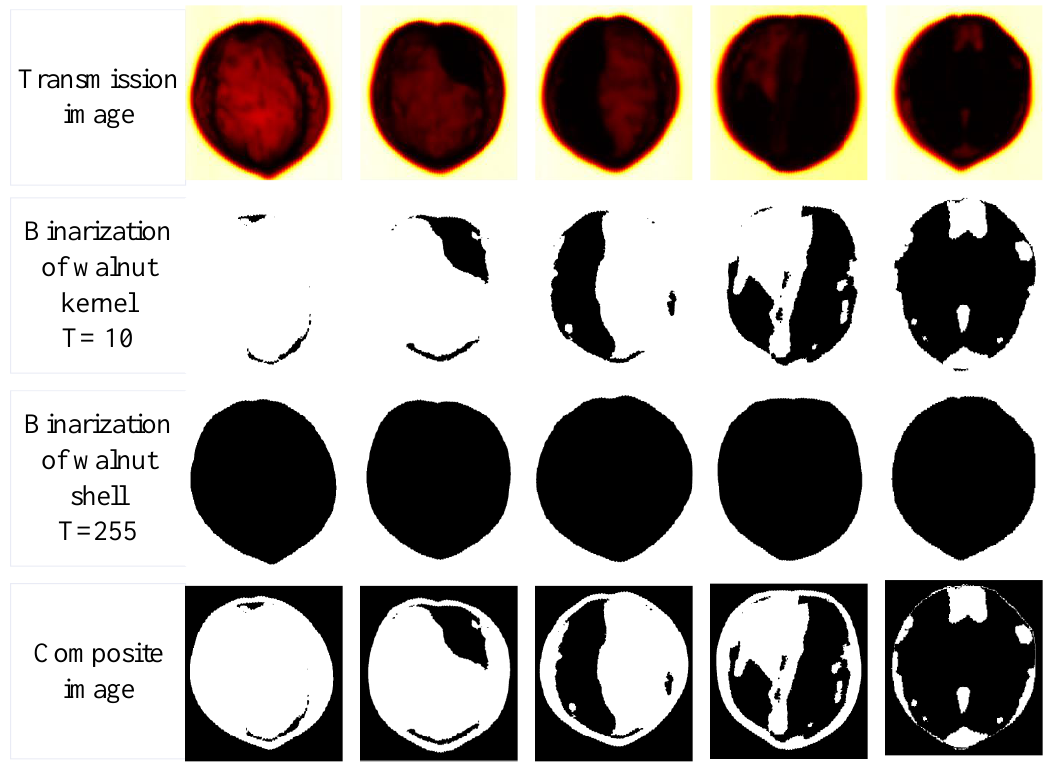
Figure 9. Terahertz transmission image processing flow of five types of samples with different plumpness. Table 4. Calculation results of walnut kernel fullness by walnut transmission images.